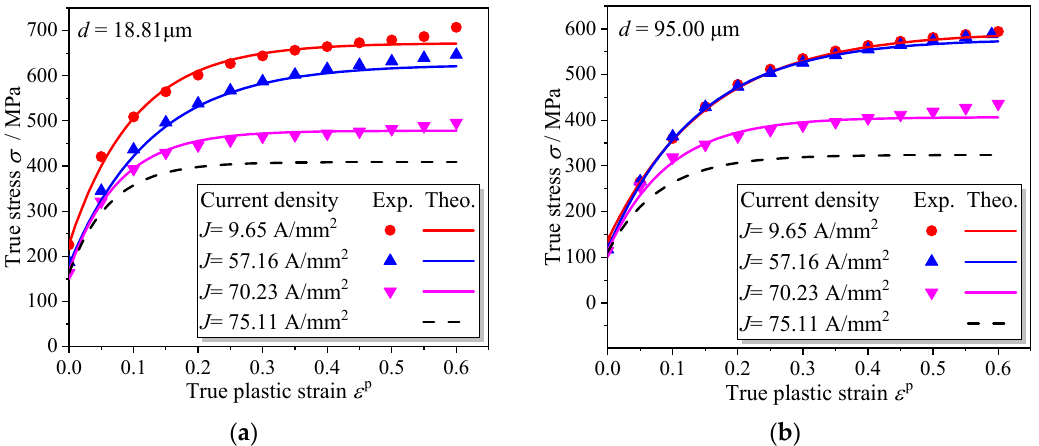
Figure 9. Experimental and theoretical prediction of true stress–true plastic strain curves of electro- assisted micro-compression under different grain sizes and current densities: ( a ) 18.81 µ m; ( b ) 95 µ m.